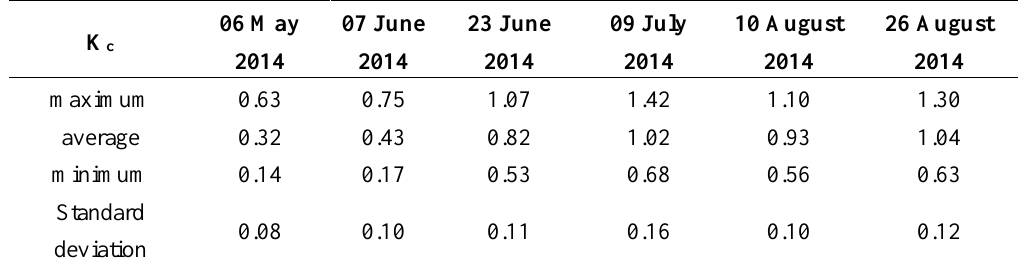
Table 4. Statistical parameters for K c values derived from Landsat 8 satellite images from the year 2014 ( n = 110